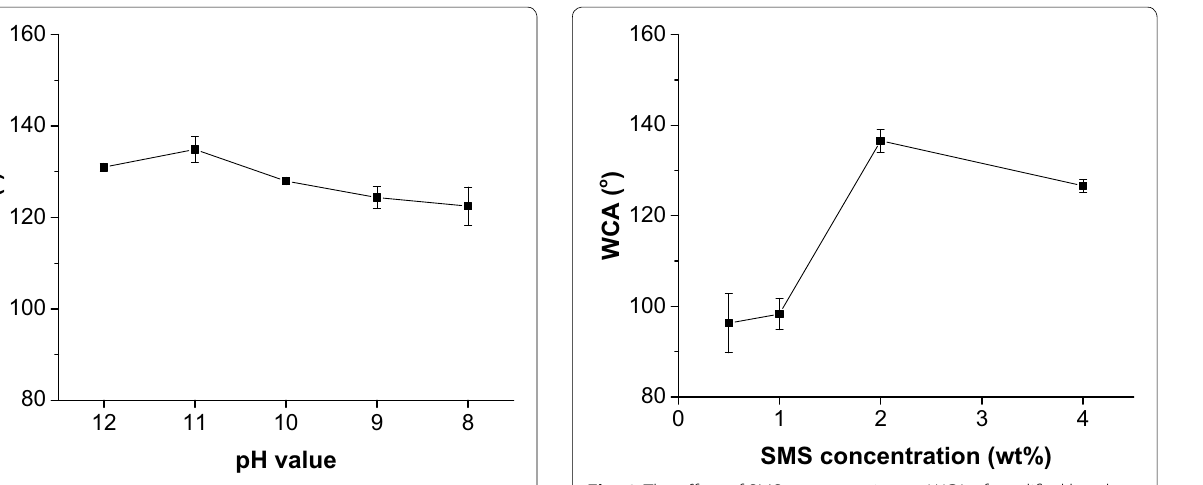
Fig. 5 The effect of pH value on WCA of modified bamboo Fig. 6 The effect of SMS concentration on WCA of modified